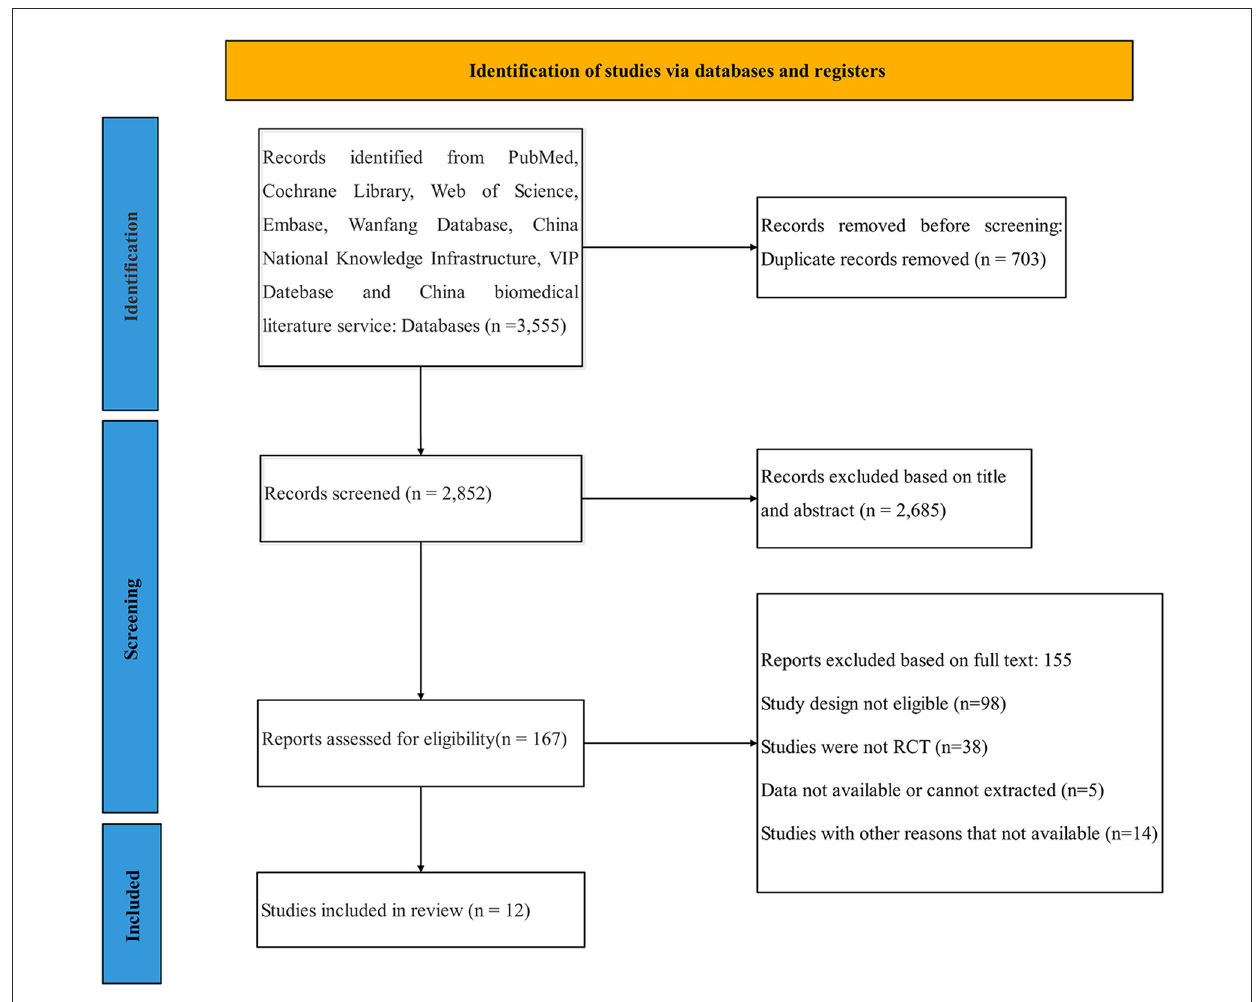
FIGURE1 Literature review